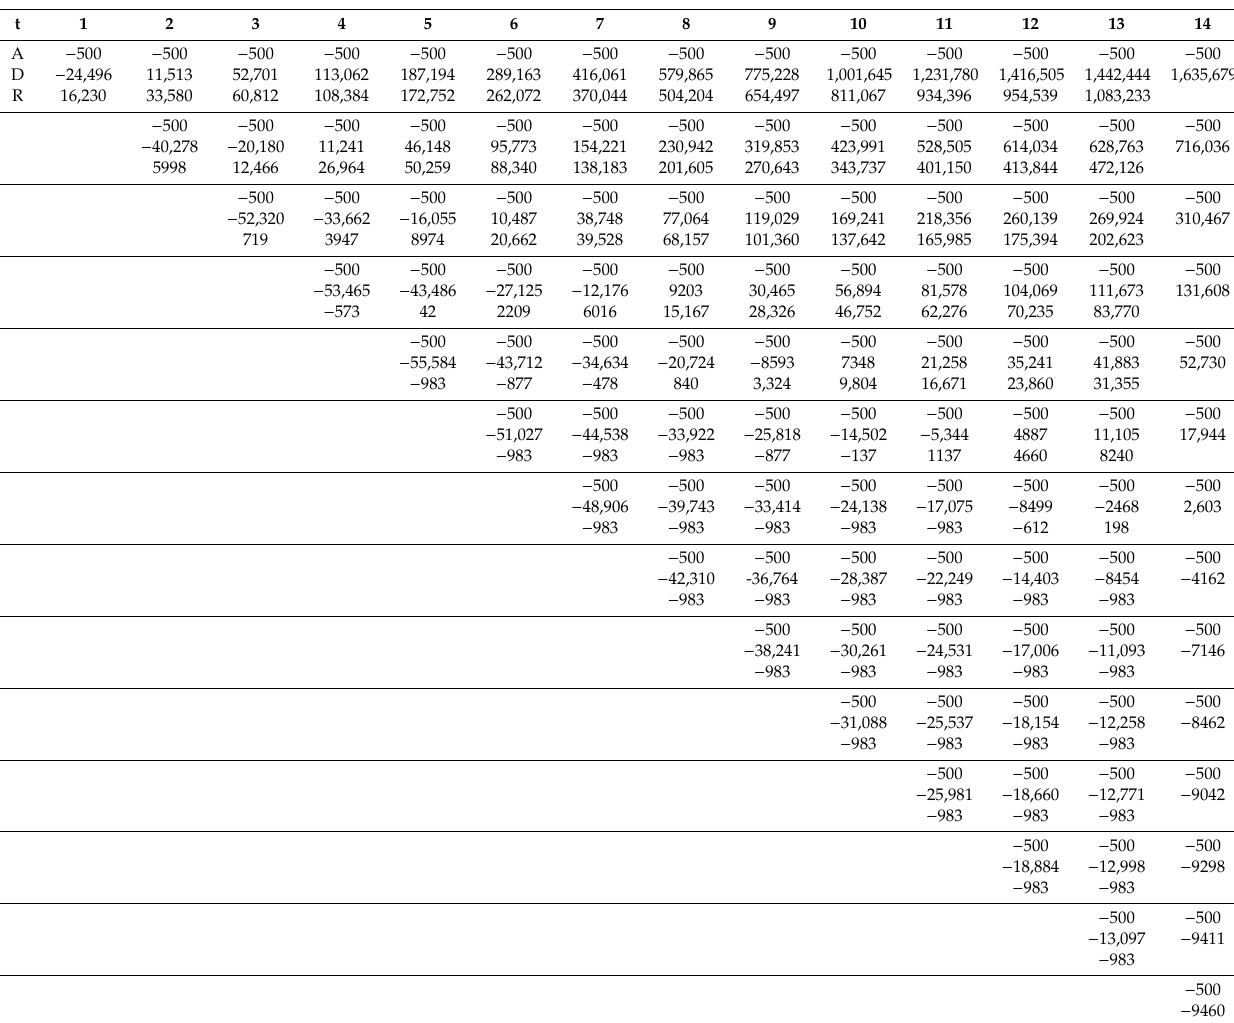
Table 3. Binomial lattice of option values (Unit: Billion